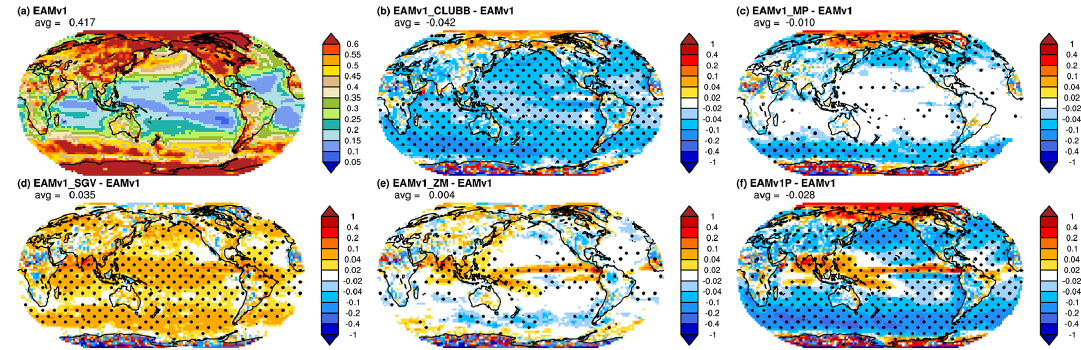
Figure 8. Cloud-top entrainment efficiency (Bretherton et al., 2007). The cloud-top entrainment efficiency is computed at every cloud physics time step (d t = 5min) of the model. Table 8. Global mean 10-year-averaged precipitation fields of EAMv1, EAMv1_CLUBB, EAMv1_MP, EAMv1_SGV, EAMv1_ZM, and EAMv1P. Relevant precipitation variables listed here are total, convective, and large-scale precipitation rates (PRECT, PRECC, and PRECL, respectively; unit = mmd − 1 ); ratio of deep convective precipitation to total precipitation ( R conv ); frequency of occurrence (unit = %) of